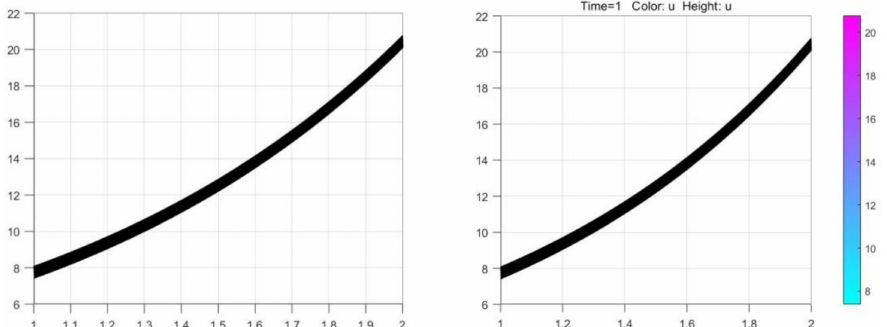
Figure 9. Cross-sectional